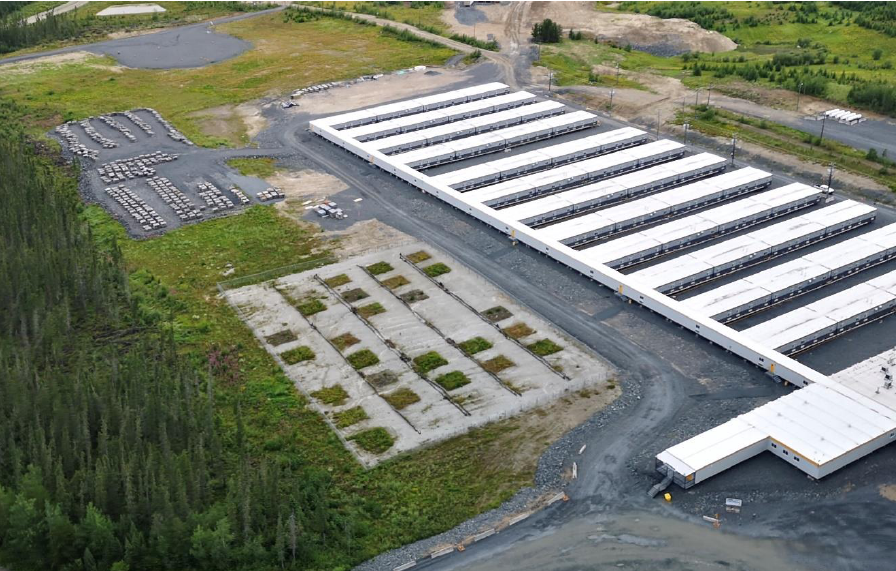
Figure 1. Aerial photo of the reclamation field trial at the Detour Lake Mine.